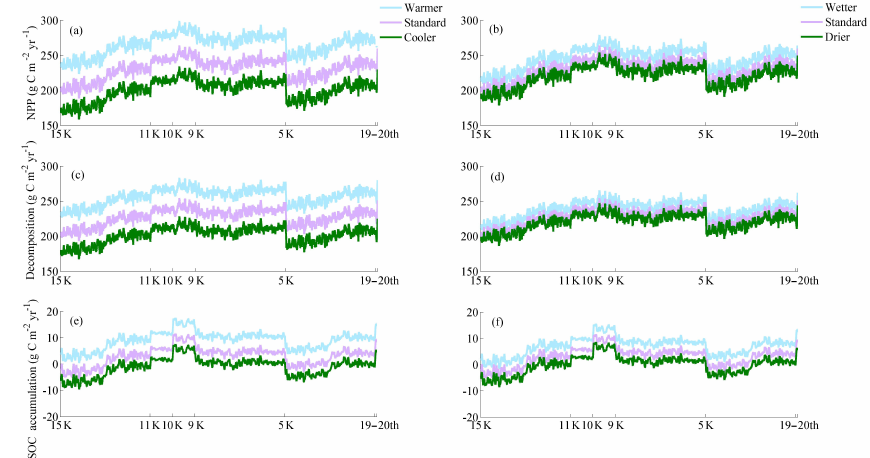
Figure 14. Temperature and precipitation effects on (a, b) annual NPP, (c, d) annual SOC decomposition rate (aerobic plus anaerobic), and (e, f) the annual SOC accumulation rate of Alaska. A 10-year moving average was